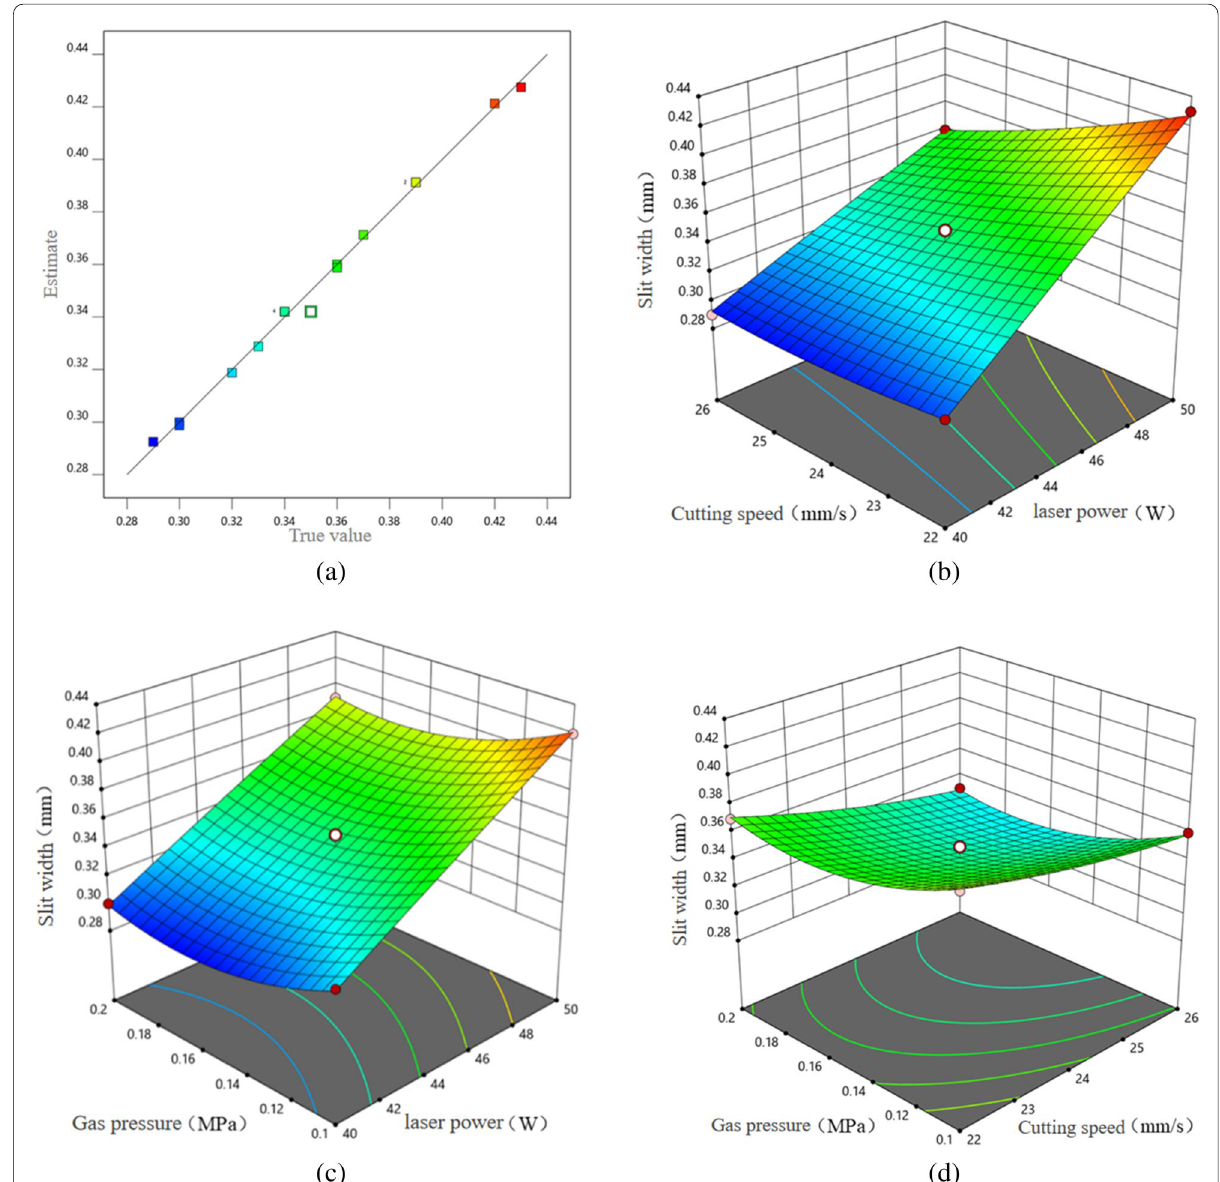
Fig.10 Response surface diagram of cutting width of inert gas-assisted laser cutting wood. a Comparison between predicted and actual. b Interaction of laser power and cutting speed. c Interaction of laser power and gas pressure. d Interaction of cutting speed and gas